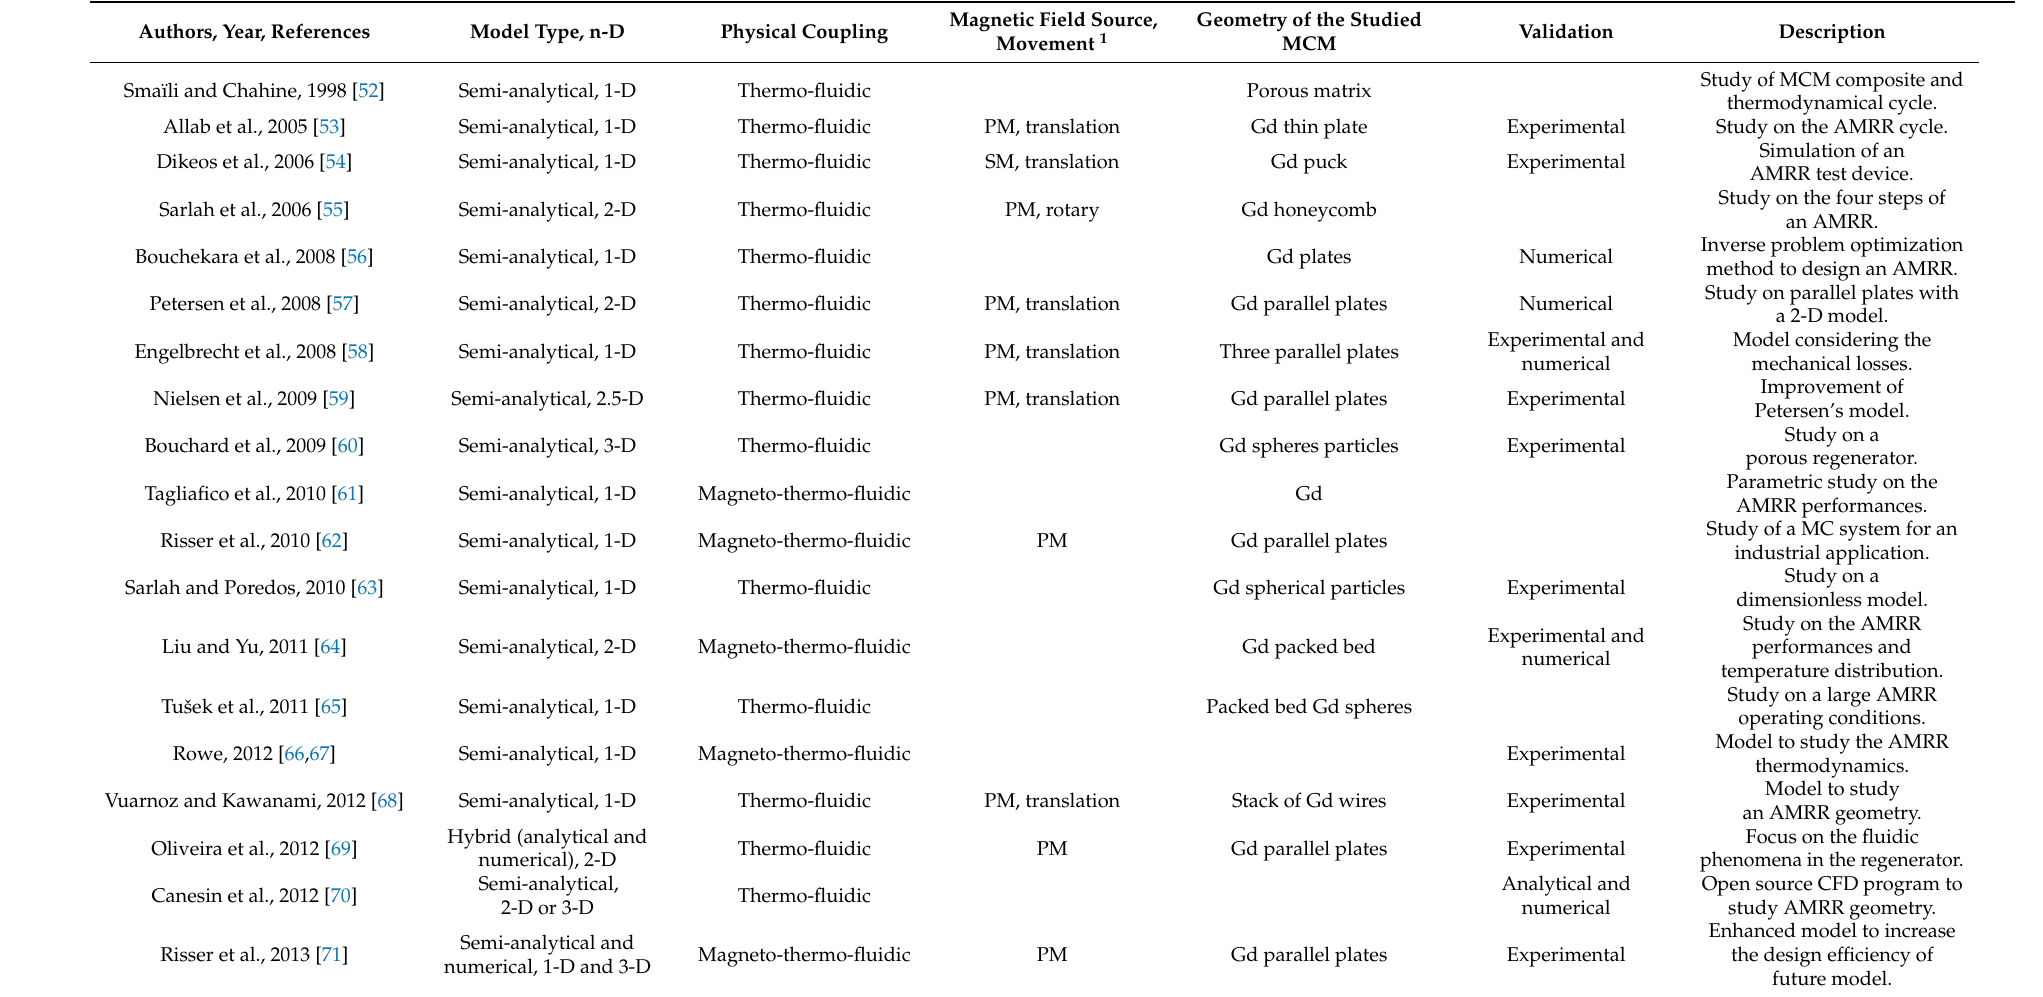
Table 1. Models’ synthesis and